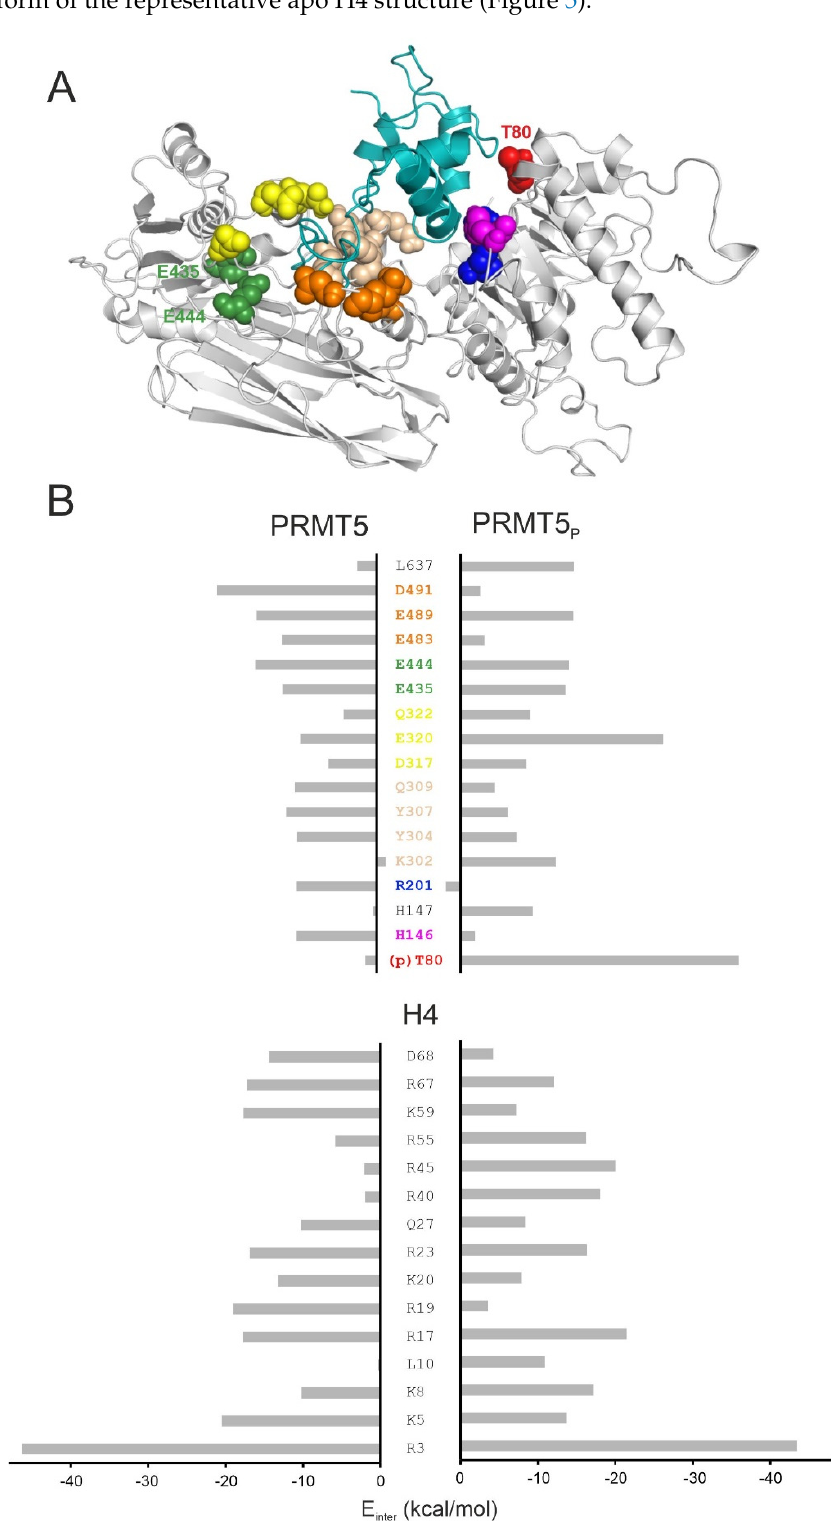
Figure 3. ( A ) The representative structure of the unmodified H4-PRMT5 complex in the pre-product state (P2 in Figure 1B). Note that MEP50 is not shown in this figure due to space restrictions. For the structure of the full H4-PRMT5-MEP50 complex, please refer to Figure S4. Enzyme residues with the lowest E inter are highlighted with colours and spheres, represented in both the structure and the energy bar chart; ( B ) E inter values are calculated for the enzyme and the histone H4 residues in the unmodified PRMT5 and the phosphorylated (PRMT5 P ) complexes in the pre-product (P2) state.